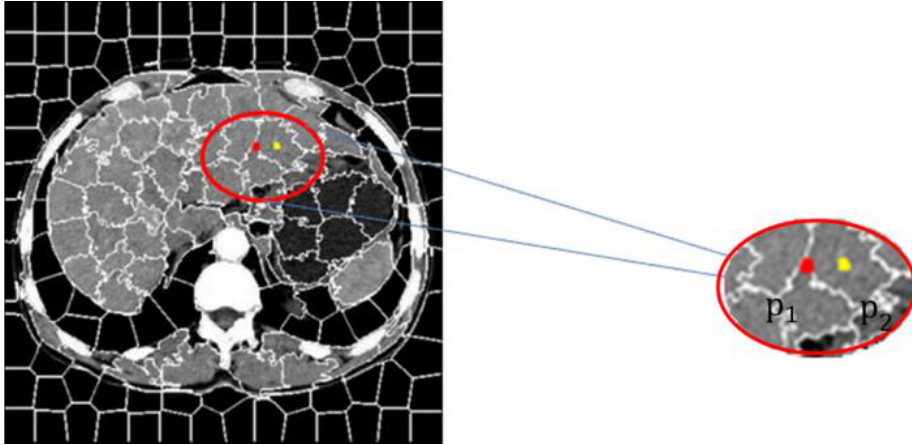
Figure 1. Central pixel located at the edge and inside of the superpixel.